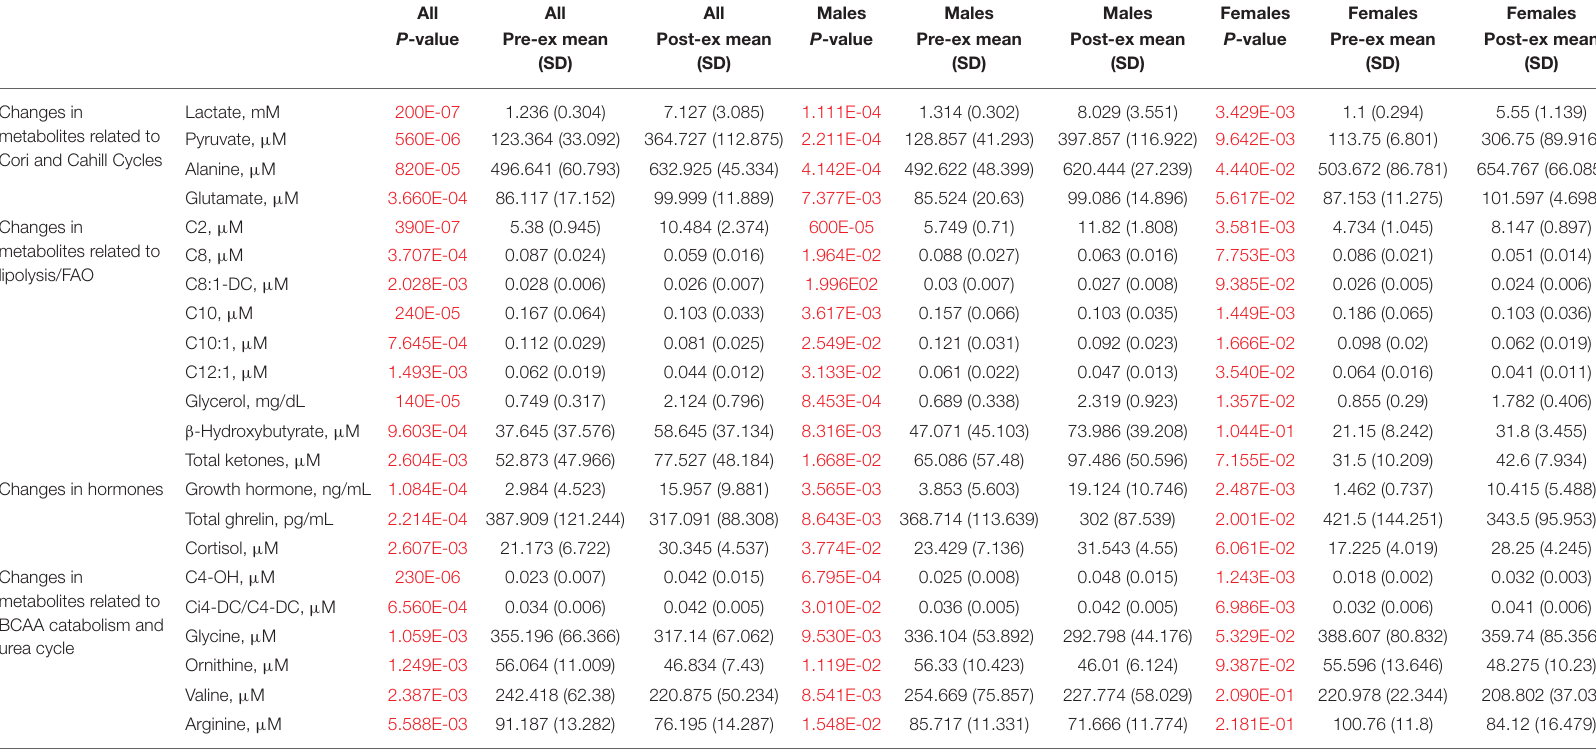
TABLE 3 | Changes in hormones and metabolites in response to acute maximal aerobic